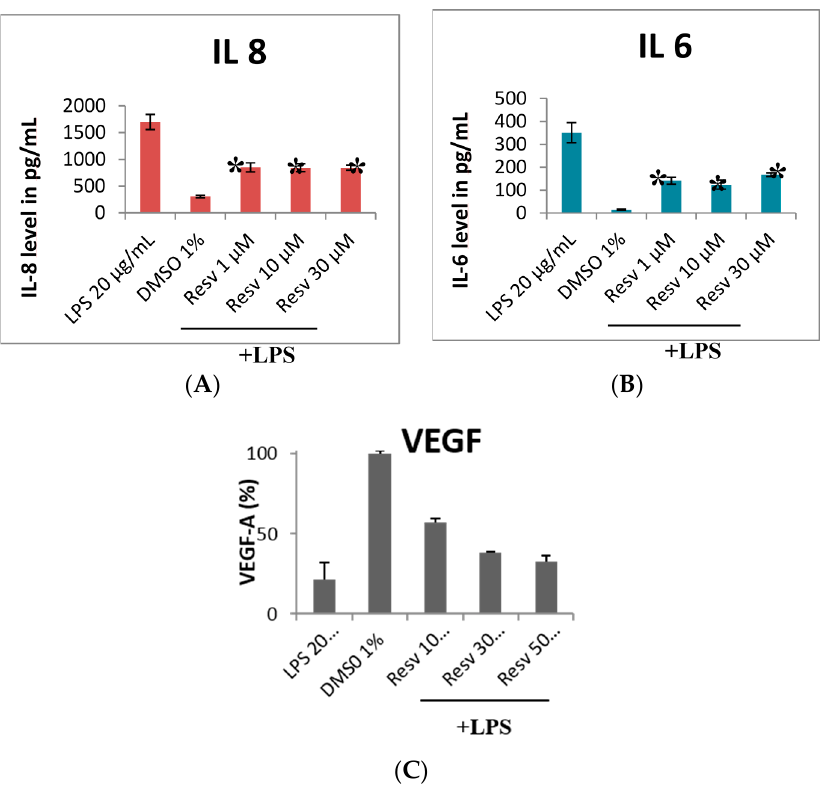
Figure 2. Interleukins and VEGF-A assays on resveratrol-treated retina ARPE-19 cell lines. Data are mean ± SD ( n = 3); 1% of solvent DM SO was used as a vehicle in all treatments. Mann-Whitney Test * p ≤ 0.05.